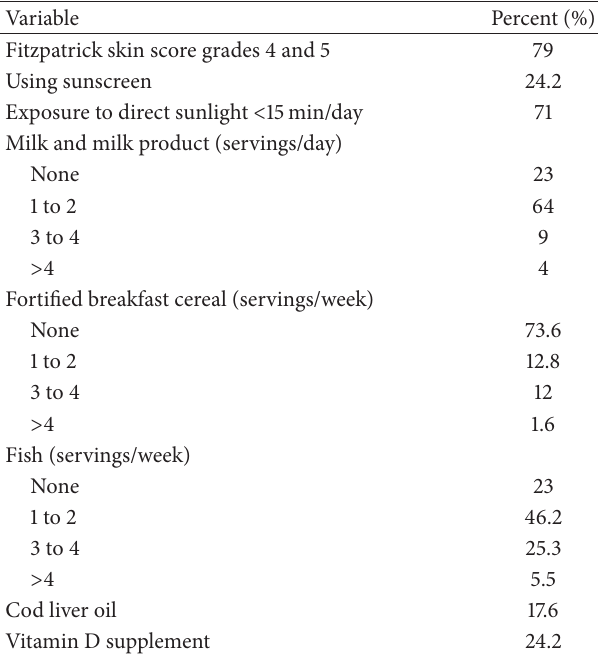
Table 1: Participants’ responses to questionnaire on lifestyle, dietary intake, and supplemental vitamin D.